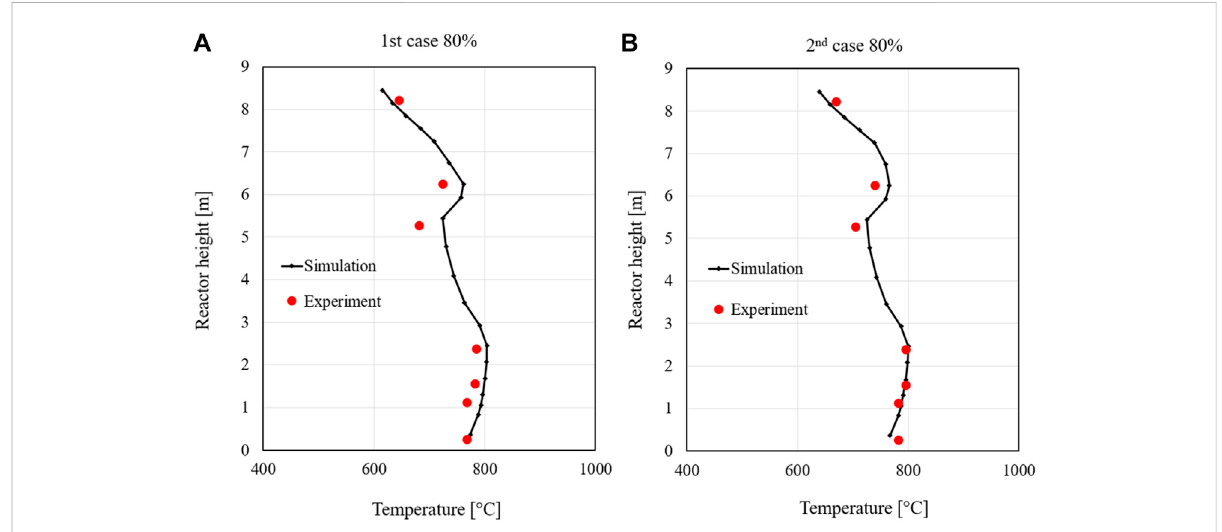
FIGURE 13 Temperature pro fi les along the riser at two 80% load cases: the fi rst (A) and the second (B) .